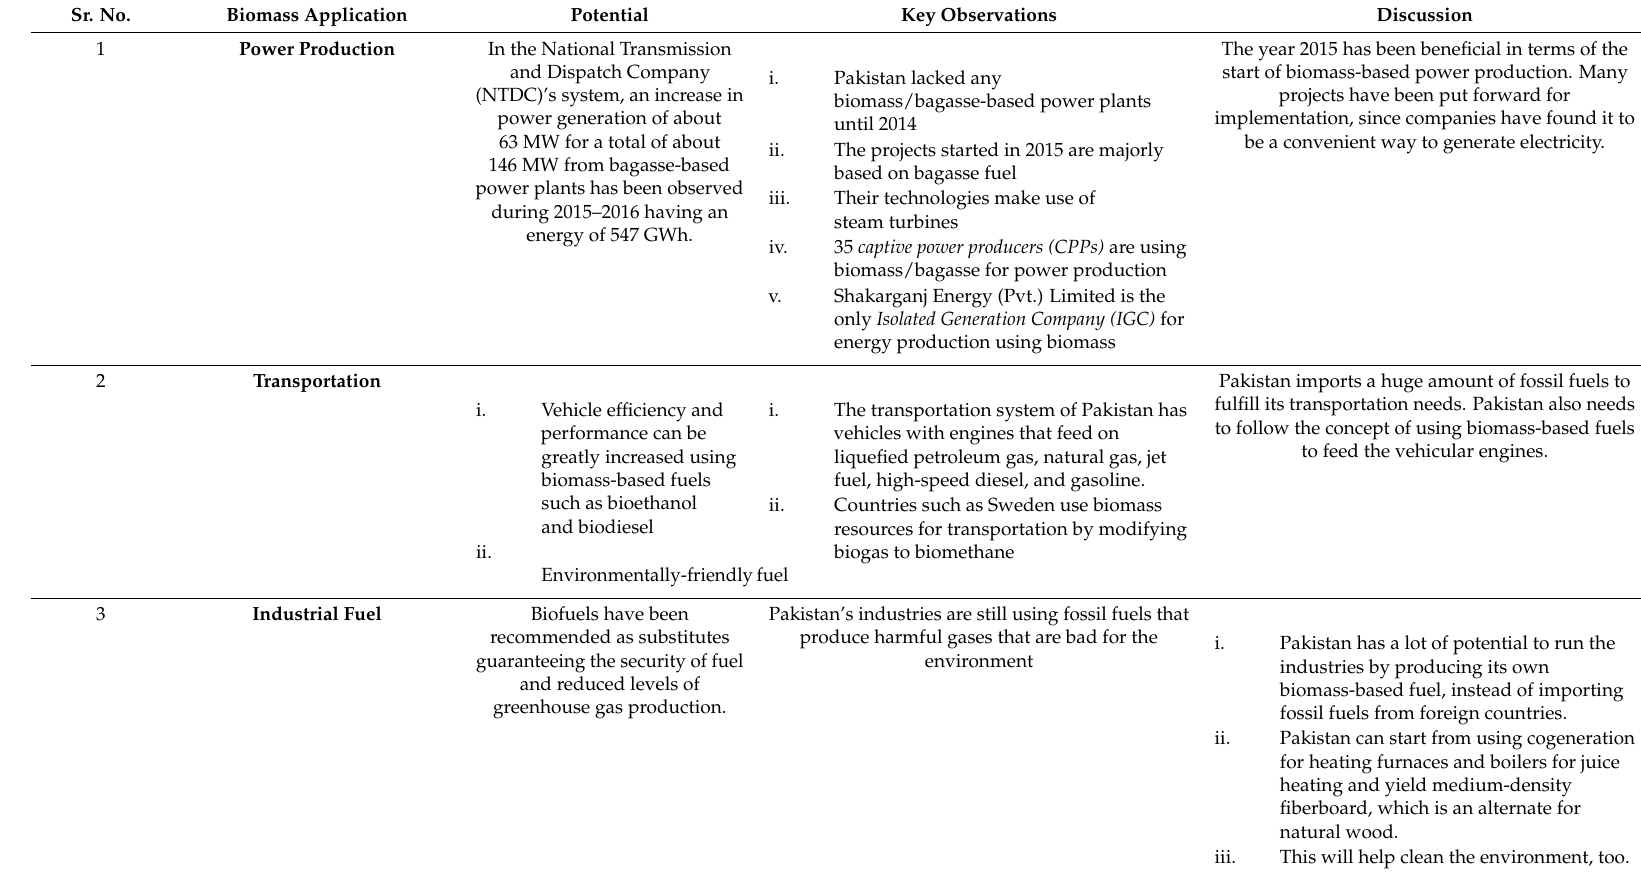
Table 28. Biomass utilization in Pakistan for power production, transportation, and industrial fuel. Sr.